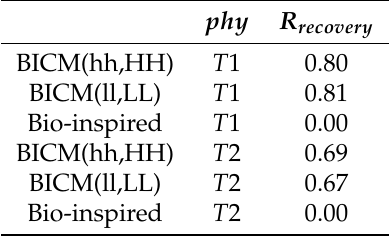
Table 3. Rate of recovering the data delivery ratio ( R recovery ) against random